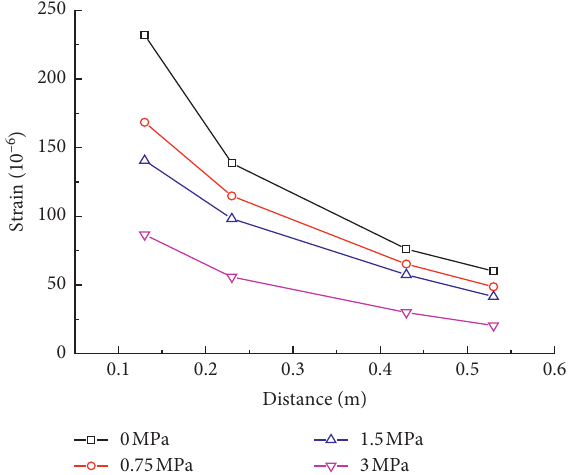
Figure 17: Time-history curves of radial strain of measuring point in intact rock mass without initial stress.